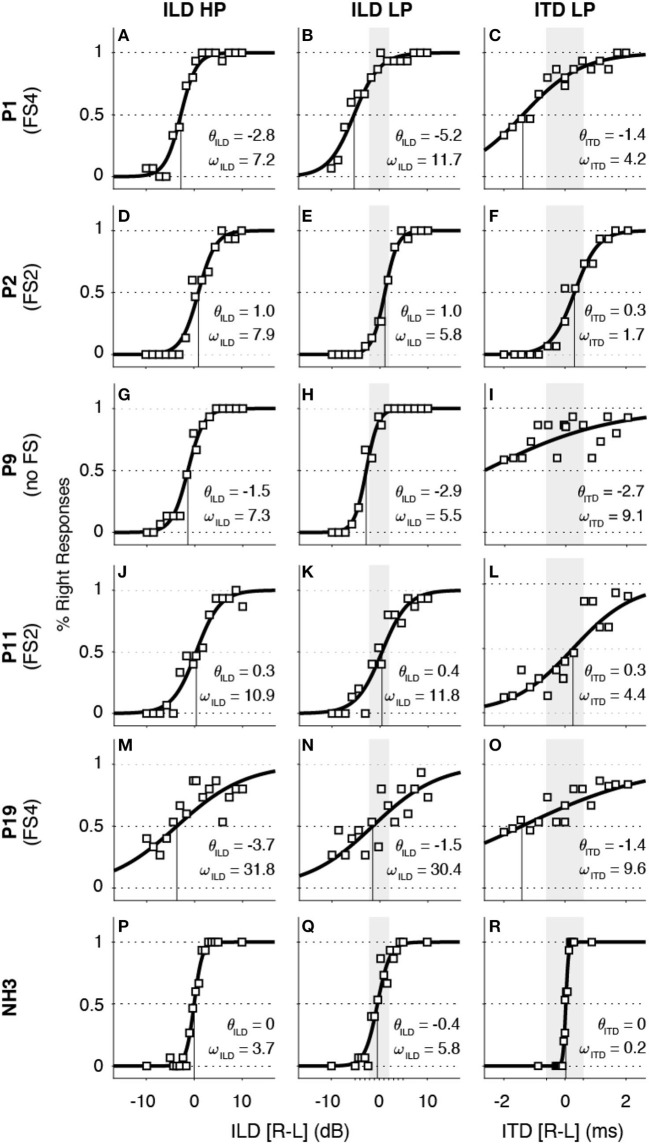
Interaural level difference (ILD, left and middle columns) and interaural timing difference (ITD, right column) data and sigmoid fits for four representative examples of BICI listeners (A–O) and one normal-hearing (NH) control (P–R). In all ITD panels, the gray area indicates the physiological range for ILD low-pass (LP, ±2 dB) and ITD LP (±600 μs) that is within the stimulus intensity range. Note that four out of five CI-users demonstrate some variable ITD sensitivity within the physiological range and that all show ILD high-pass (HP) sensitivity.